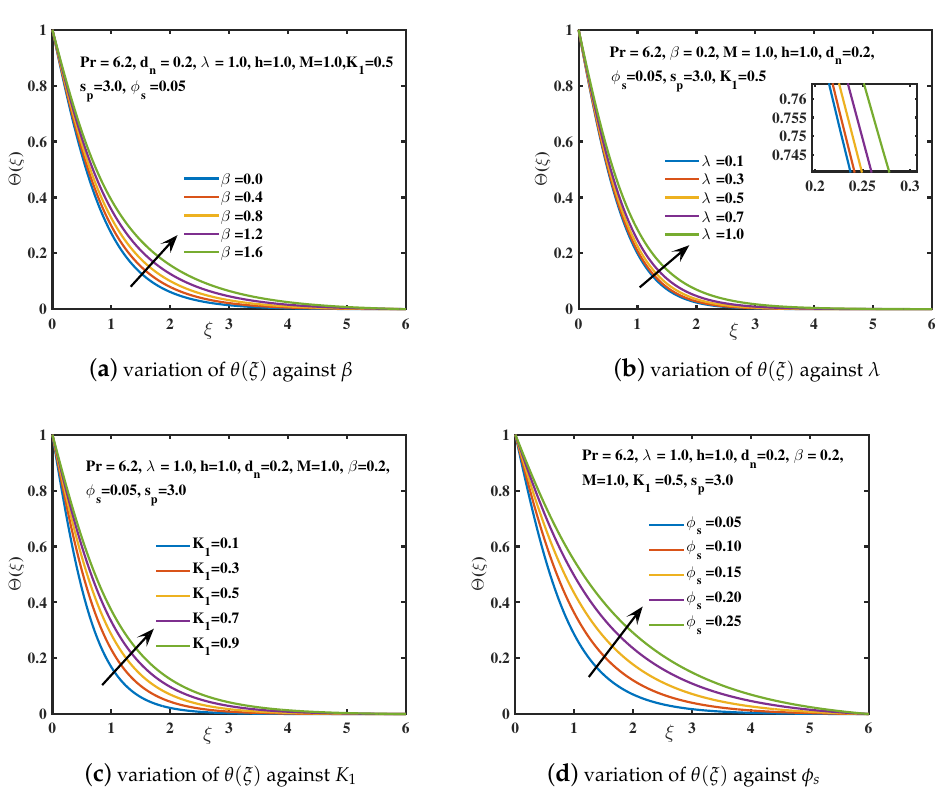
Figure 9. The effect of β , λ , K 1 ,and φ s on temperature curve.